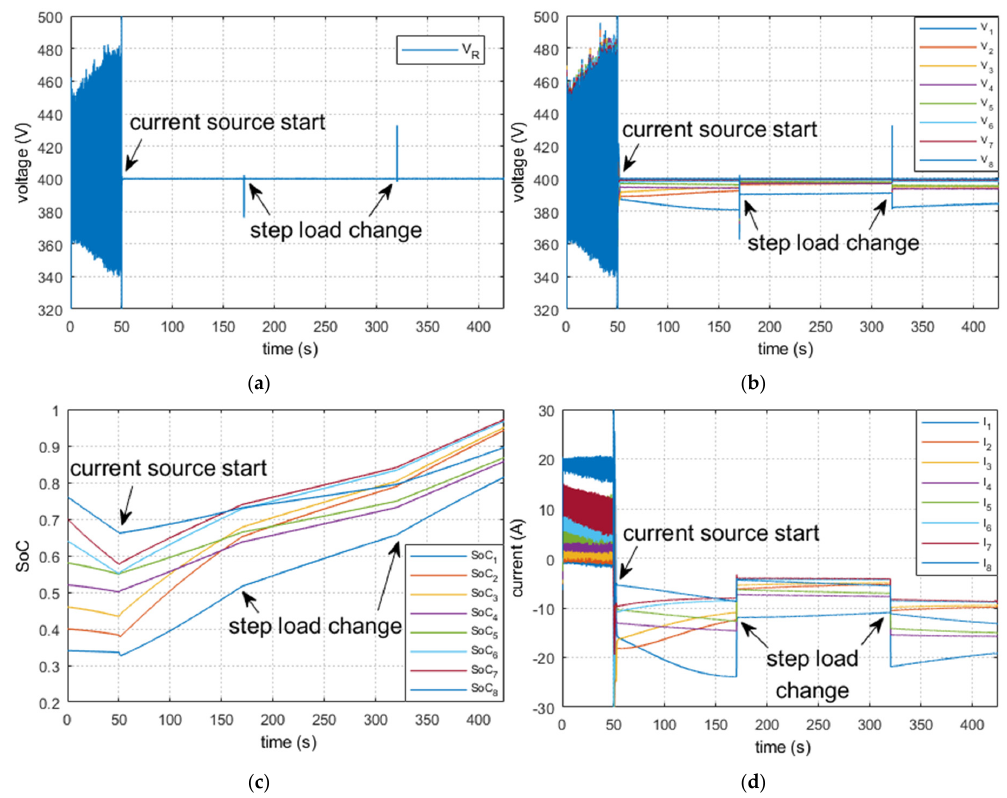
Figure 8. Comparative simulation results: ( a ) voltage at the remote load; ( b ) dynamic voltages; ( c ) SoCs; ( d ) output currents.